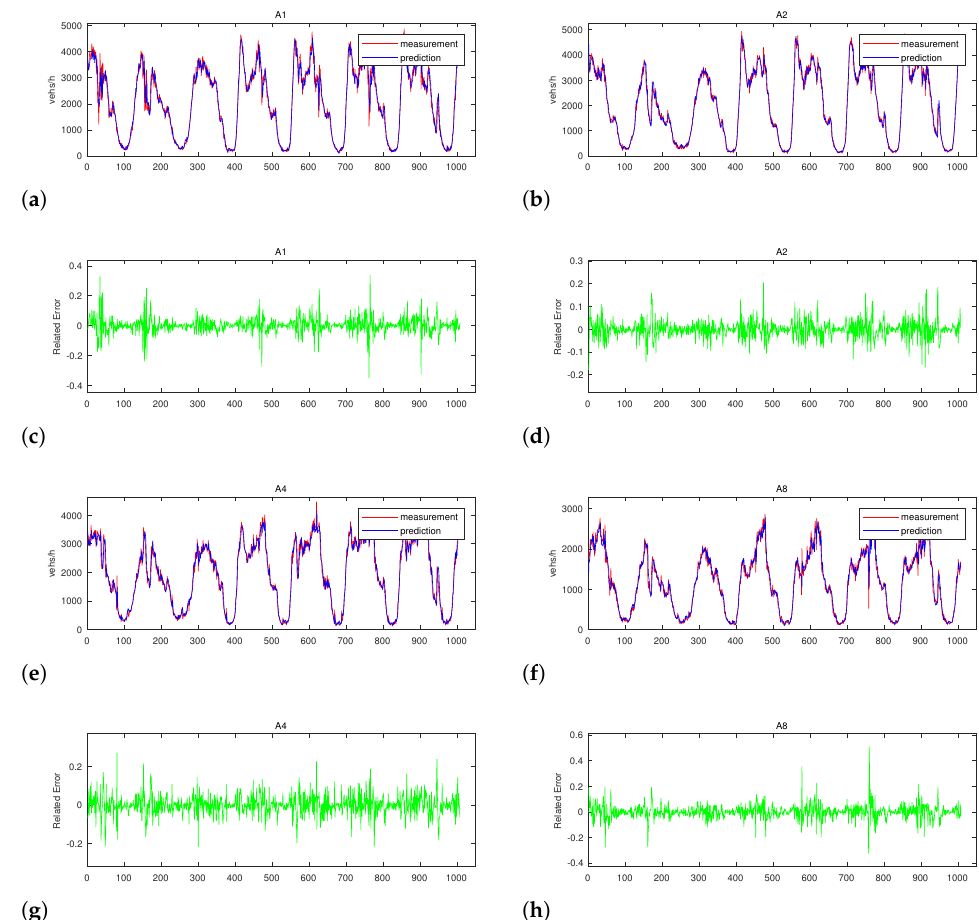
Figure 6. The ( a – h ) represent the forecasting–measurement value comparison plots and the forecasting–measurement value relative error of ABC-ELM model under four training